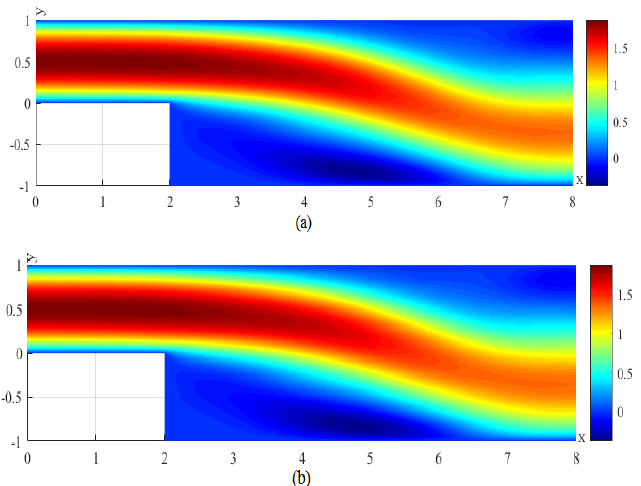
Figure 10. ( a ) The CNMFE solution for u at t = 8. ( b ) The RDRCNMFE solution for u at t = 8.